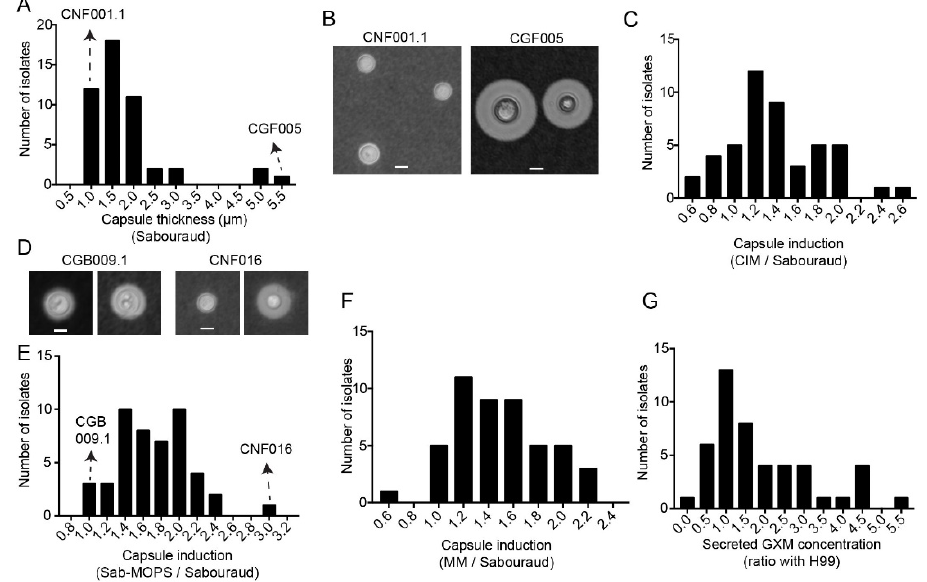
Figure 2. Capsule size of and GXM secretion by clinical isolates. ( A ) Frequency distribution of the capsule thickness in Sabouraud medium (Sab), n = 48. ( B ) Representative photo of isolates at both ends of the capsule thickness distribution, CNF001.1 isolate less than 1 μ m thick and CGF005 isolate greater than 5 μ m. ( C ) Frequency distribution of capsule induction in CO 2 -independent medium (CIM) relative to Sabouraud (CIM/Sabouraud), n = 47. ( D ) Representative photo of isolates at both ends of the relative distribution, isolate CGB009.1, which maintained the same capsule thickness in both media, and isolate CNF016, whose capsule was about three times larger in Sab-MOPS media ( n = 48) and ( E ) frequency distribution of capsule induction in Sab-MOPS relative to Sabouraud (Sab-MOPS/Sabouraud). ( F ) Frequency distribution of capsule induction in minimum medium (MM) relative to Sabouraud (MM/Sabouraud), n = 48. ( G ) Frequency distribution of secreted GXM concentration, n = 46. Experiments were repeated at least twice and had similar results. Scale bars in all panels are 5 μ m.